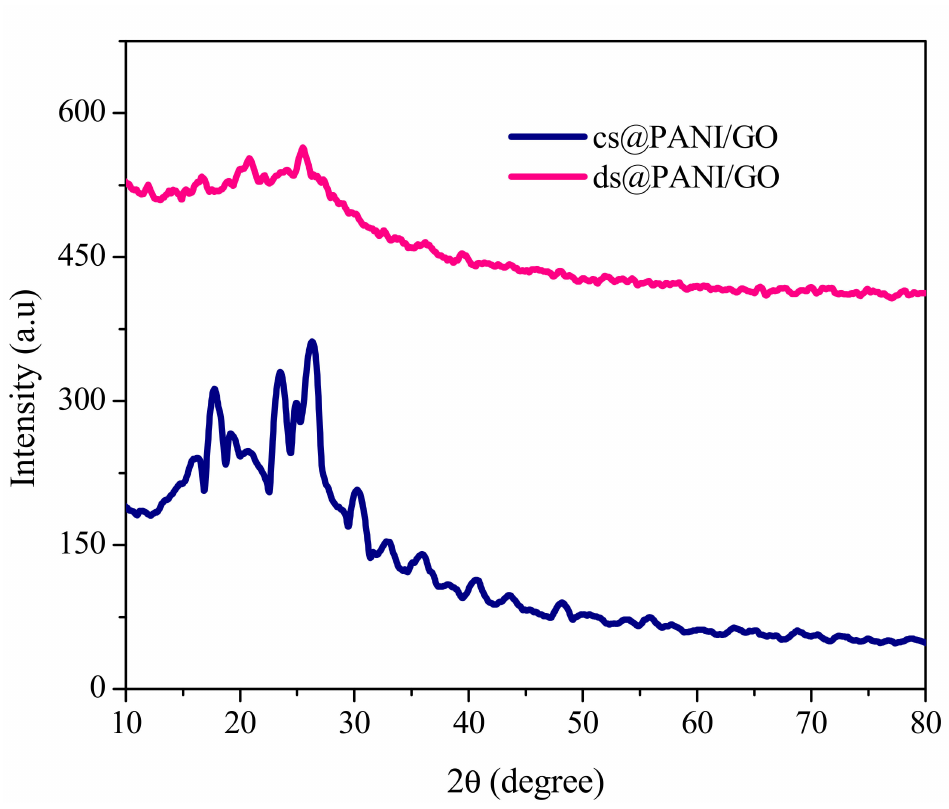
Figure 3. XRD patterns of ds@PANI / GO and cs@PANI /